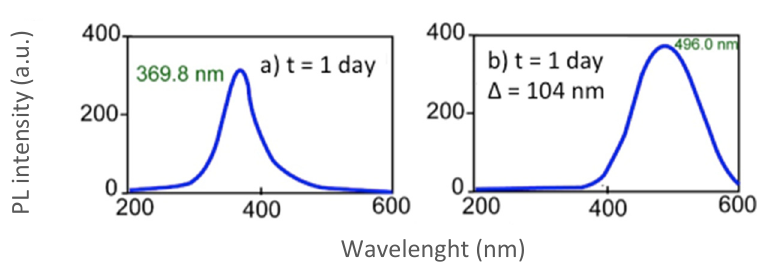
Figure 2. Photoluminescence behavior of the CdS-BSA QDs 1 day after synthesis under the general conditions described. Excitation and emission slit widths R ex = R em = 10 nm. ( a ) Excitation spectrum at λ em 496.0 nm. ( b ) Emission spectrum at λ ex 369.8 nm.